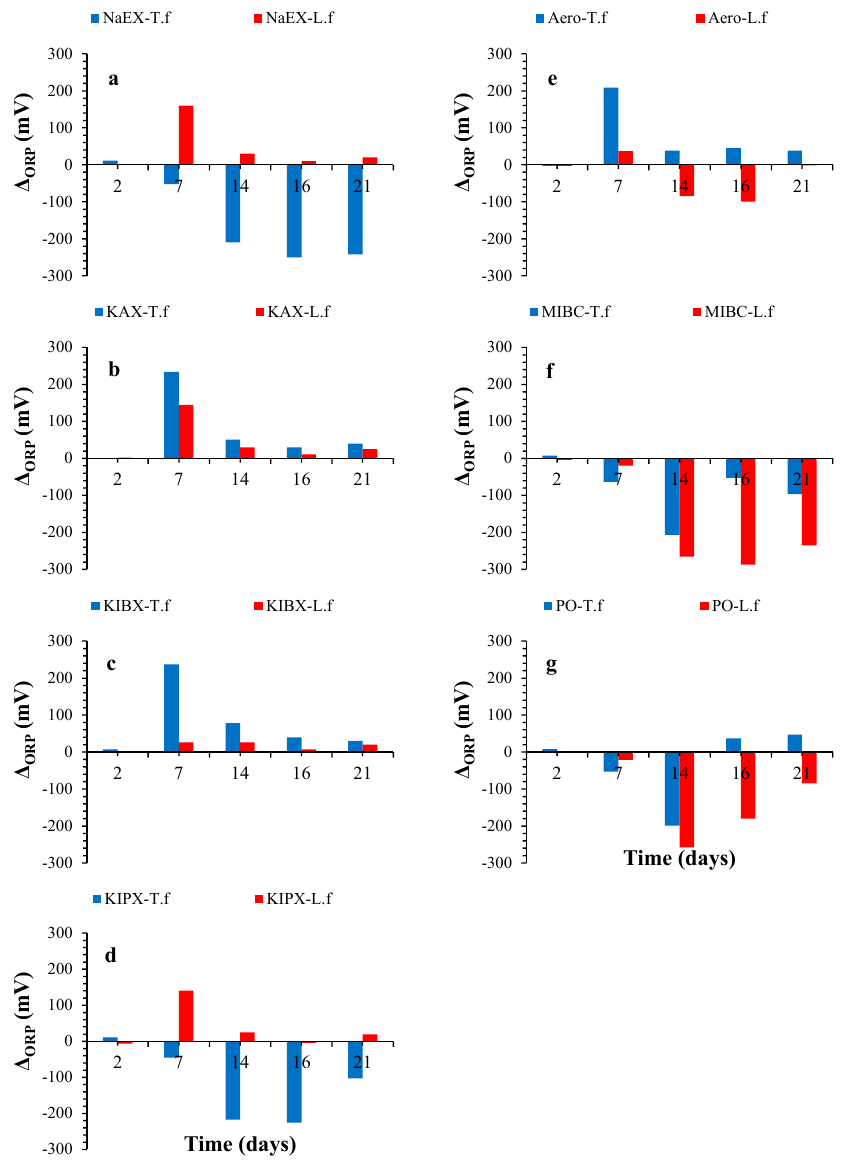
Figure 2. Effects of various flotation reagents on ORP during L. ferrooxidans and T. ferrooxidans activities.